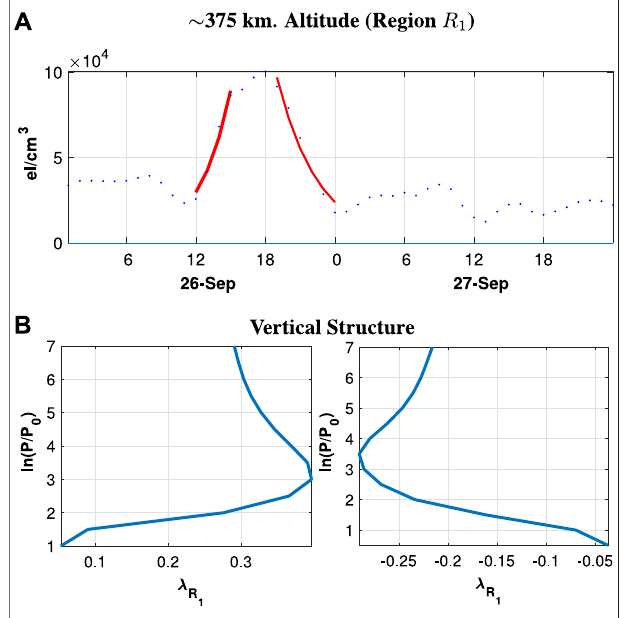
FIGURE 5 | (A) RMSE time series of electron density bias in units of el / cm 3 , at pressure level 3.5 ( ∼ 375 km), averaged over all grid points in region R 1 . The horizontal axis is time in hours. The growth and decay factors used in the bias evolution operator, λ R , are shown by the red curves and are 1 applied only during the times that these curves cover. (B) Vertical structure of each λ R during the initial (left) and relaxation (right) phases of the 1 geomagnetic storm. The vertical axis is in pressure levels and the horizontal axis is the value of λ R 1